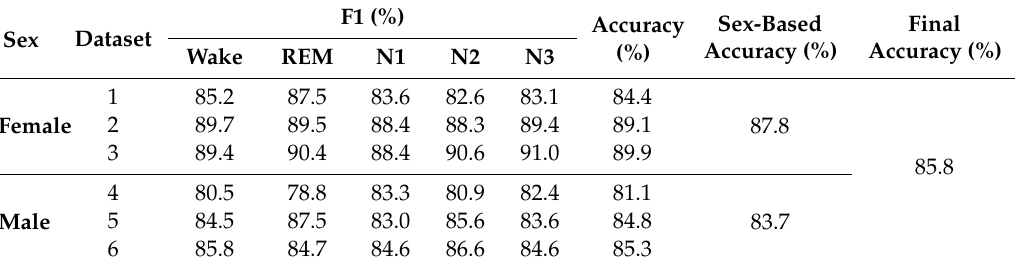
Table 3. Analysis of the classification accuracy.